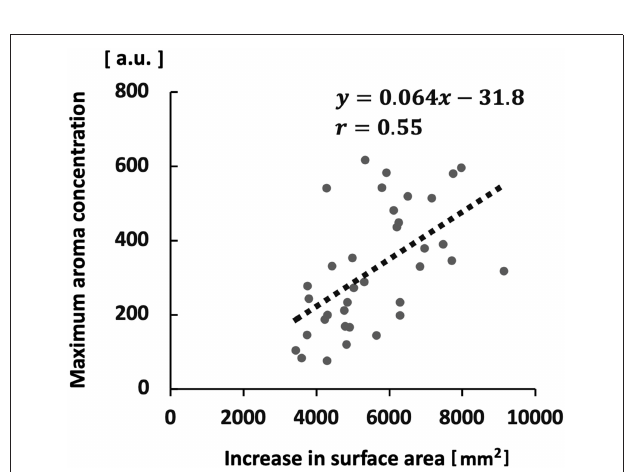
FIGURE 9 | Correlation between maximum aroma concentration and increase in surface area.